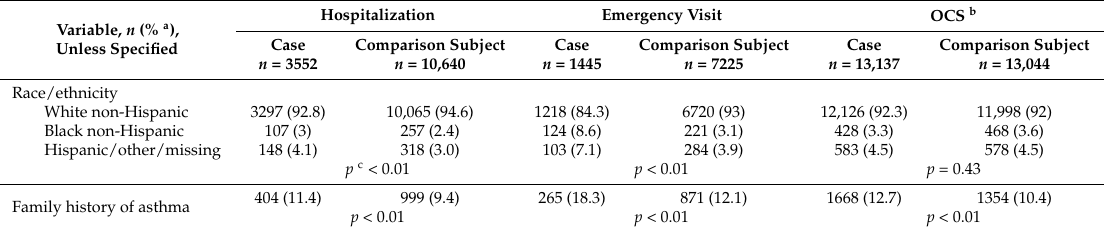
Table 1. Descriptive statistics of cases and comparison subject characteristics by exacerbation